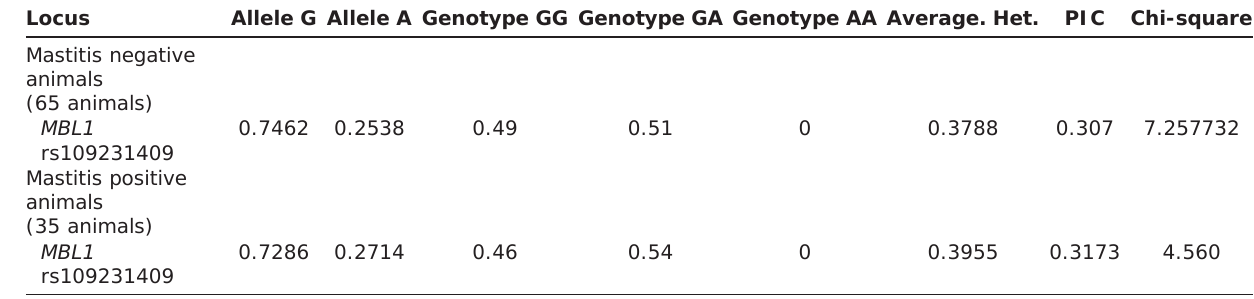
Table-1: Data of gene, genotype frequencies, average heterozygosity, PIC and χ 2 values.